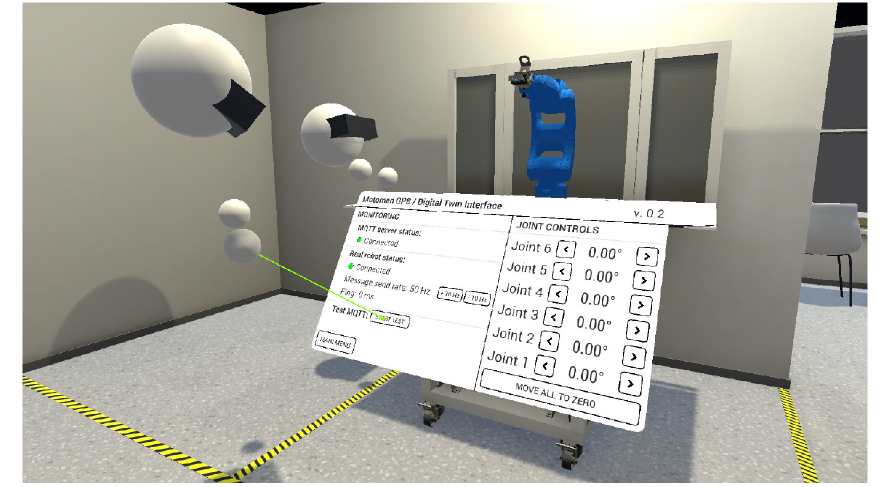
Fig. 3. Researchers’ avatars controlling the robot in VR.